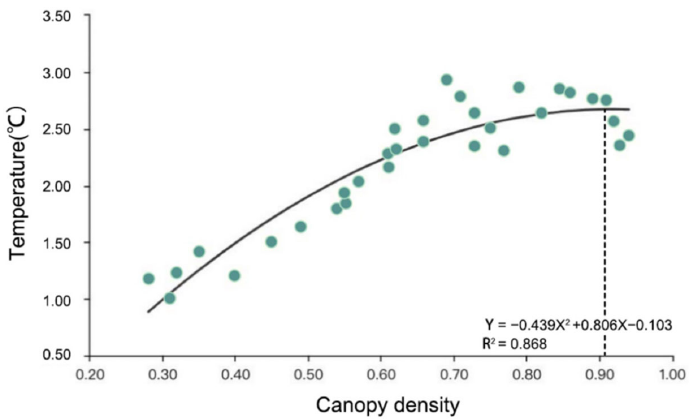
Figure 3. Relationship between temperature and canopy density.